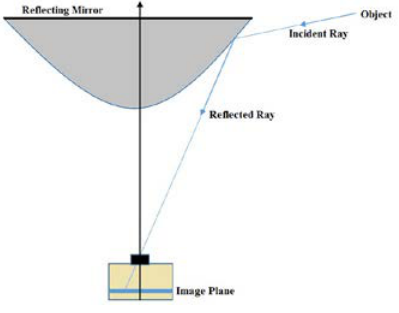
Figure 1. Concept of the catadioptric camera whole environment or the direction of movement if it is not visible. Catadioptric cameras can be further divided into two types: central and non central. A vision system is said to be central when the optical rays to the viewed objects intersect at a single point in 3D called single effective viewpoint).